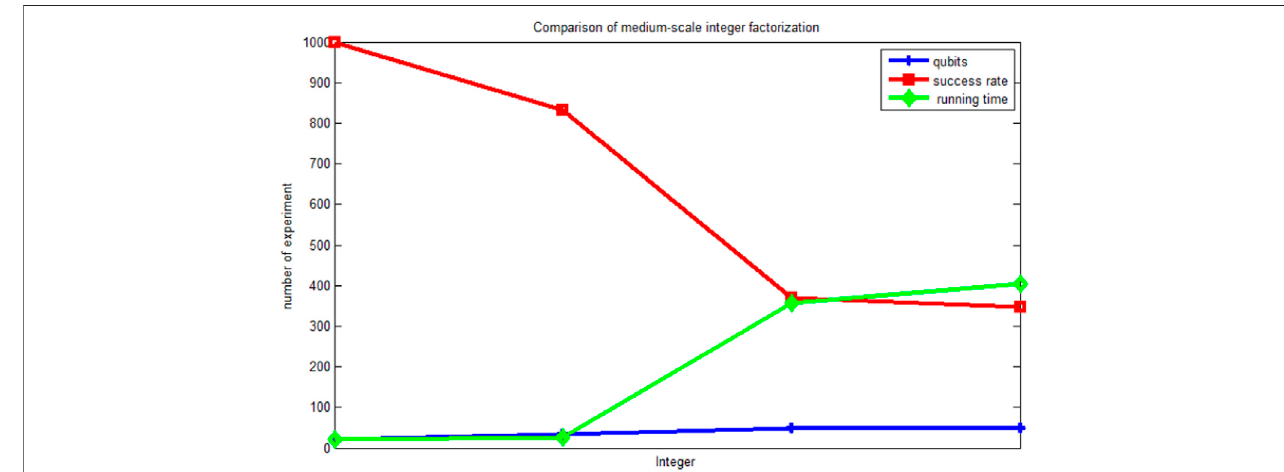
FIGURE 4 | Comparison of medium-scale integer factorization cases.